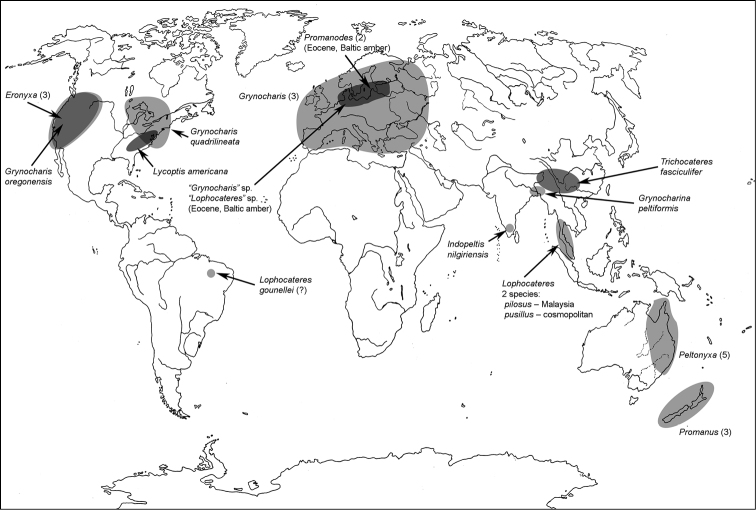
A distribution of the tribe Lophocaterini.